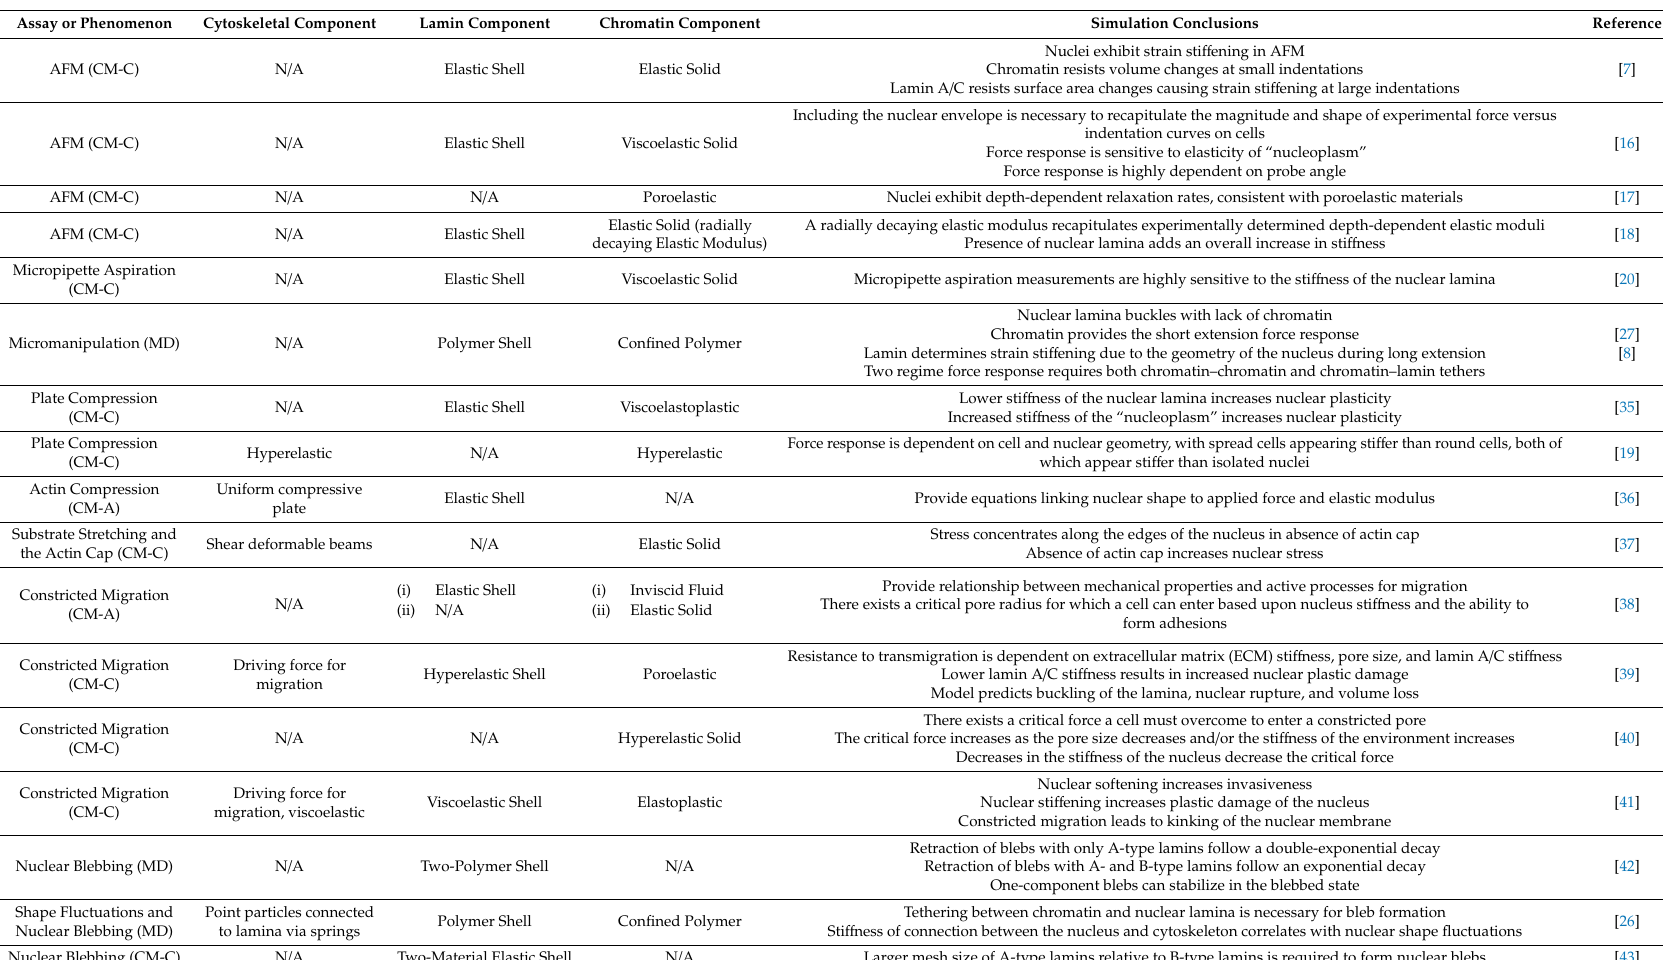
Table 2. Summary of nucleus-specific mechanical models. Column 1 additionally provides the class of model. CM-A: analytically-solved continuum mechanics model. CM-C: computationally-solved continuum mechanics model. MD: molecular dynamics